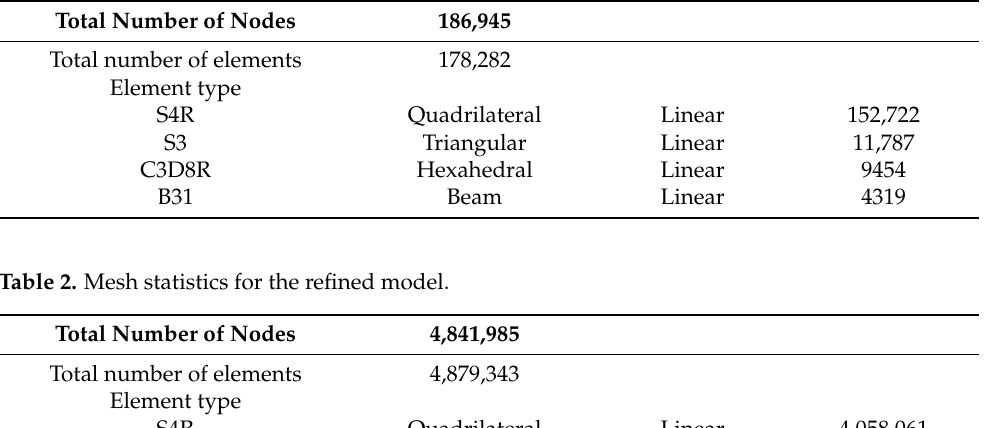
Figure 7. Examples of part seeding. Table 1. Mesh statistics for the coarse model.